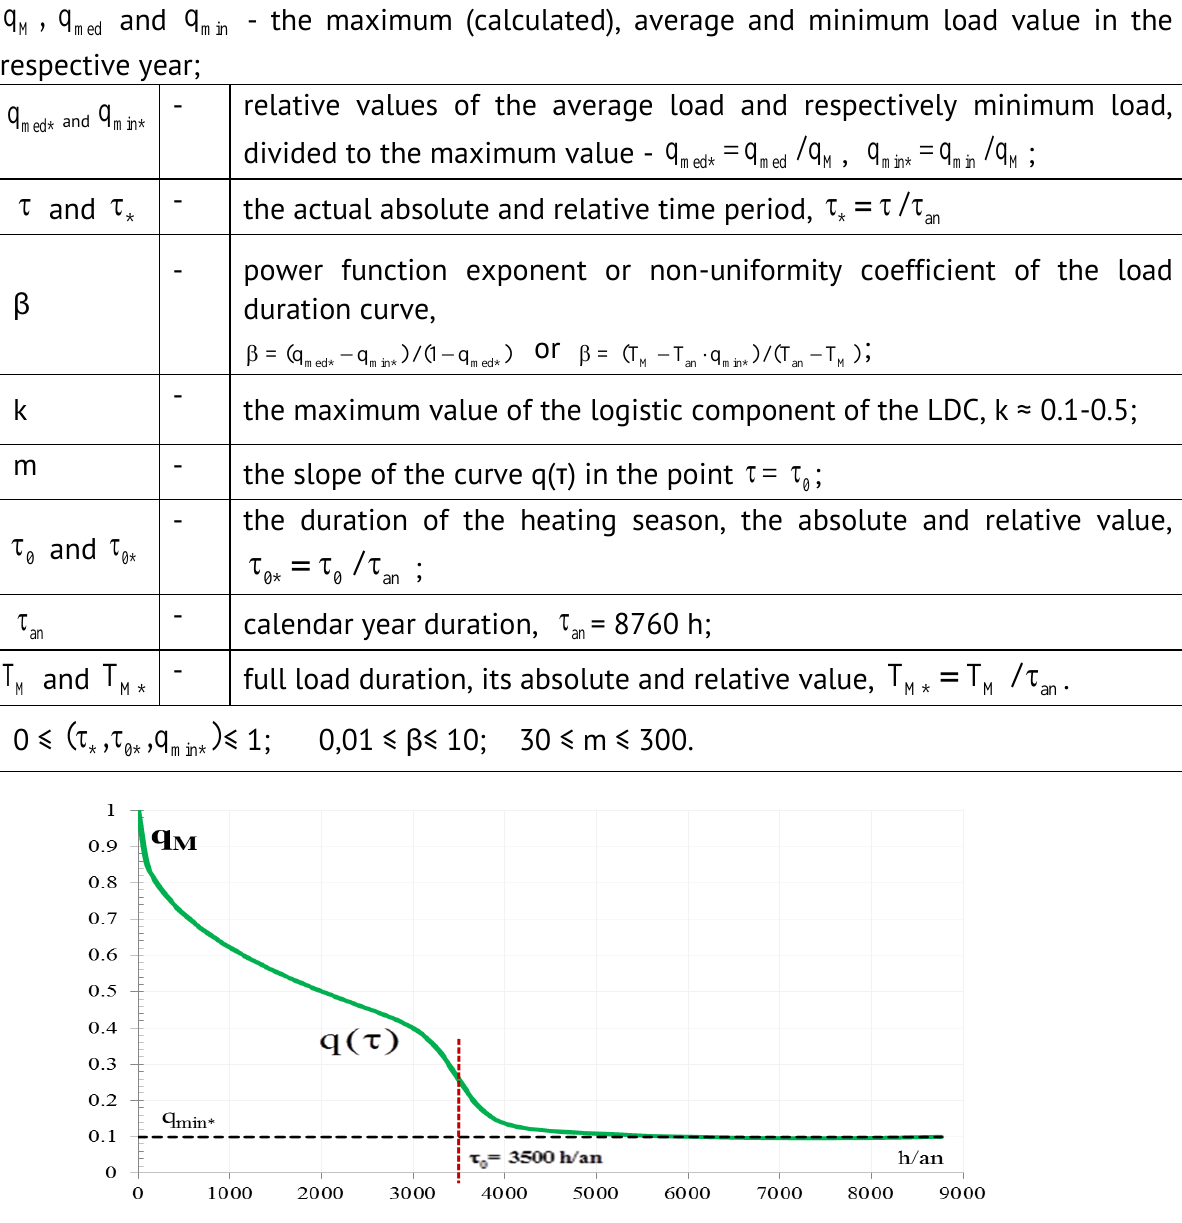
 time moment of the 0